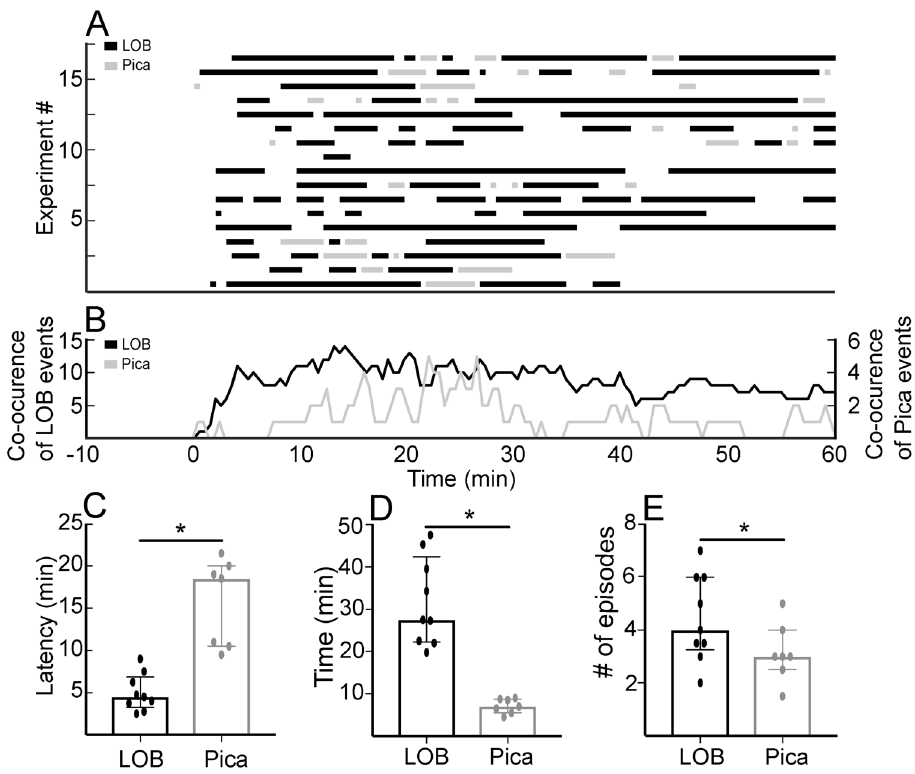
Figure 2. Quantification of behavioral events that express gastrointestinal malaise. ( A ) Graphical representation of LOB and Pica episodes after IP LiCl injection at time 0 for all the experiments. ( B ) Index of co-ocurrence of behaviors estimated as the sum of events throughout the experiments. The black and gray lines represent the cumulative LOB and Pica episodes, respectively. ( C ) Latency comparison for the first LOB and first Pica episodes after LiCl administration (asterisks, p < 0.05, Mann–Whitney test). ( D – E ) Statistical description of the behavioral expression of GI malaise. Bars represent median, whiskers the interquartile range, and asterisks a p value < 0.05 on the Mann–Whitney